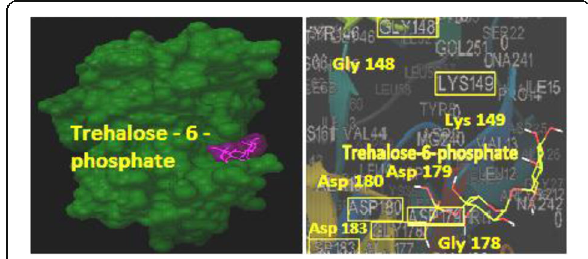
Fig. 13 a , b Docking pose of model TPP with substrate trehalose – 6 –